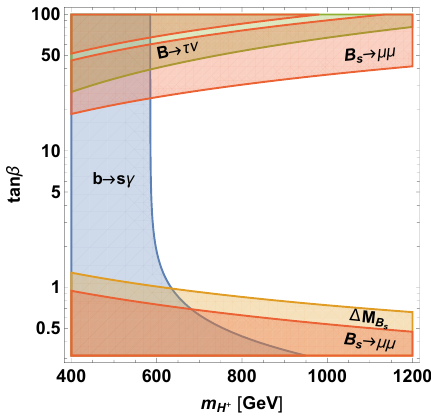
Figure 3 . The 95% CL constraints from (cid:13)avor observables. The blue, the orange, the red, and the green shaded regions are excluded by BR(b ! s (cid:13) ), (cid:1) M B